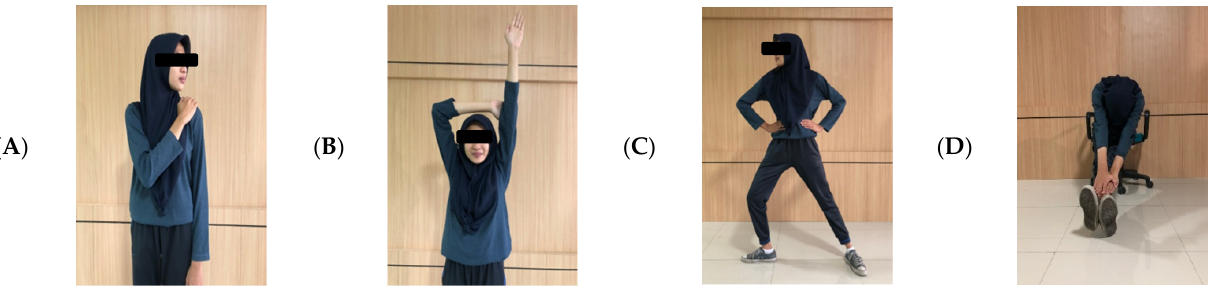
Figure 1. ( A ) Neck and shoulder stretches; ( B ) neck, shoulders, and arm stretches; ( C ) shoulder stretch; ( D ) arm and upper back stretches; ( E ) shoulders, arm, and chest stretches; ( F ) hands, wrists, finger, and forearm stretches; ( G ) upper back stretch; ( H ) back, shoulder, and arm stretches; ( I ) low back, hips, groin, and hamstring stretches; ( J ) lower leg and leg joint stretches; ( K ) lower limb and ankle stretches.